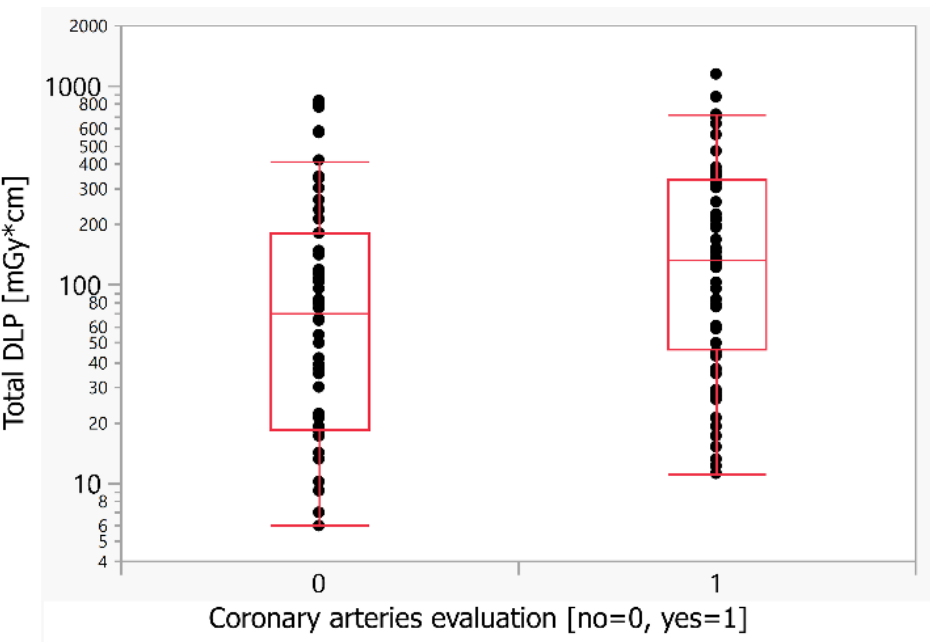
Figure 2. Comparison of the radiation dose for the coronary artery evaluation. DLP—dose length product (mGy*cm).